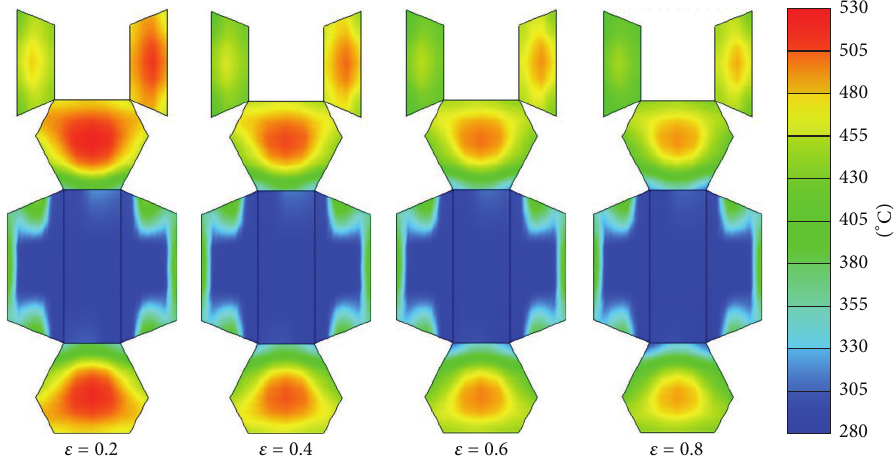
Figure 10: Distributions of temperature of cavity walls.